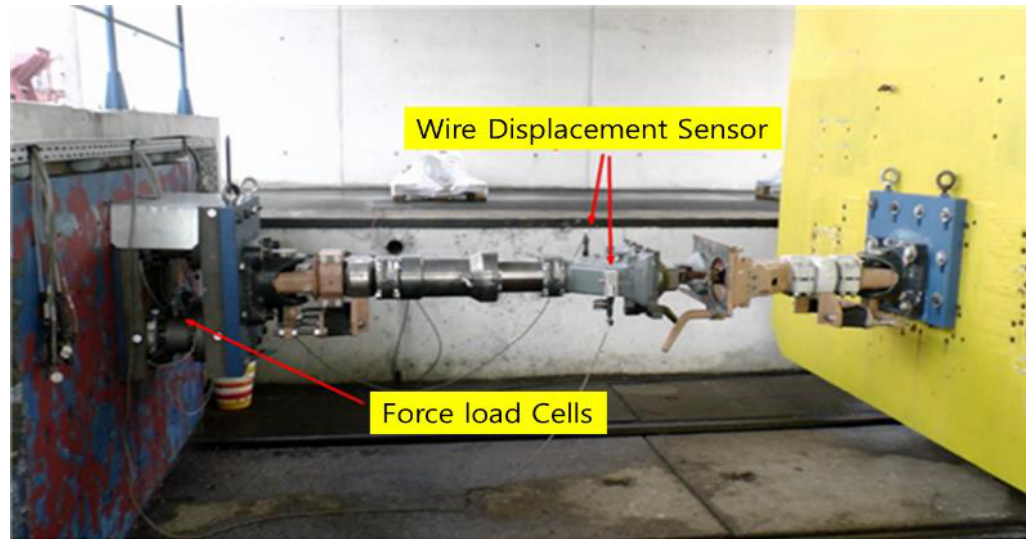
Figure 11. Photo of collision test.